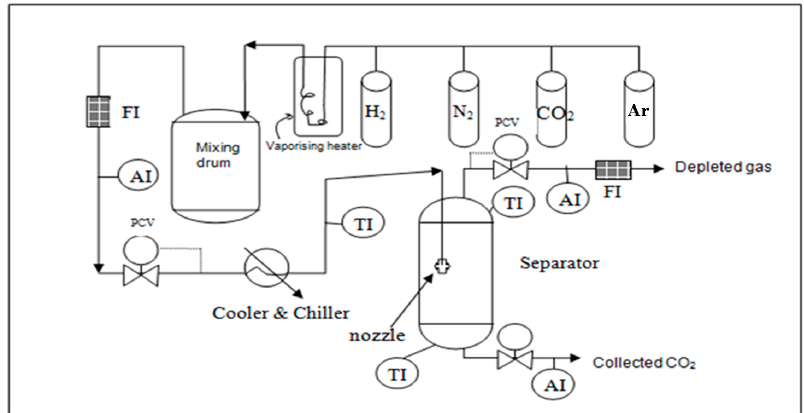
Figure 5. Laboratory pilot plant schematic (cryogenic condensation).